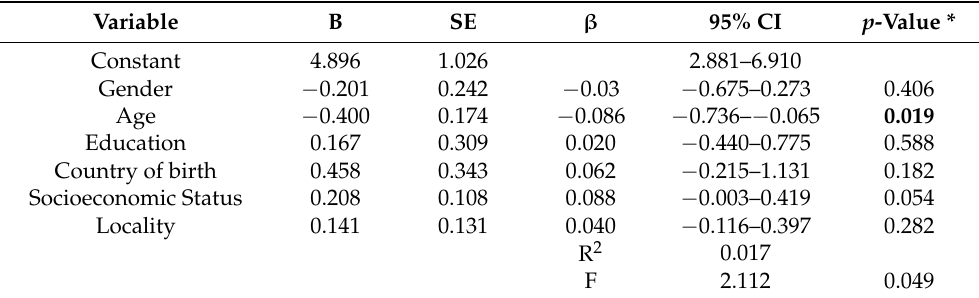
Table 5. Multiple linear regression model of dementia literacy with sociodemographic variables ( n = 764).